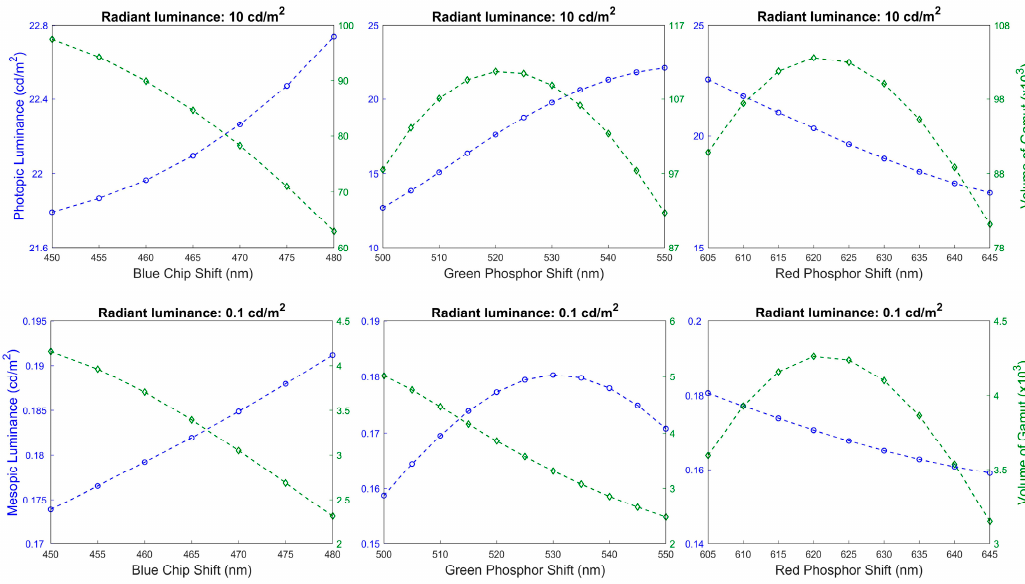
Figure 5. Characteristic of luminance and gamut volume of peak wavelength shifts (left to right: blue, green, and red).